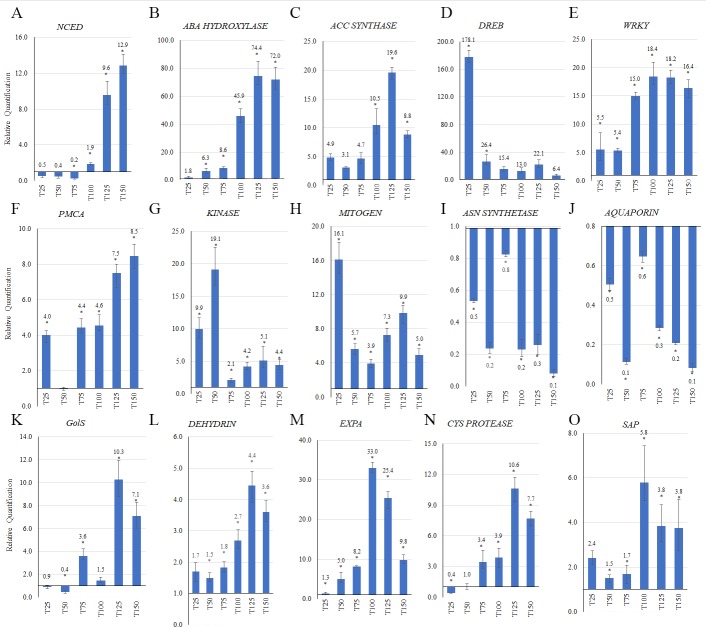
Expression of DEGs as determined by qRT-PCR.Relative quantification of mRNA levels of 15 candidate genes in A. duranensis roots during the dehydration treatment and collected after 25 (T25); 50 (T50); 75 (T75); 100 (T100); 125 (T125) and 150 (T150) min, relative to control (T0). Bars represent the standard deviation of three biological replicates. Significantly (P < 0.05) up- or downregulated genes are indicated by asterisks.